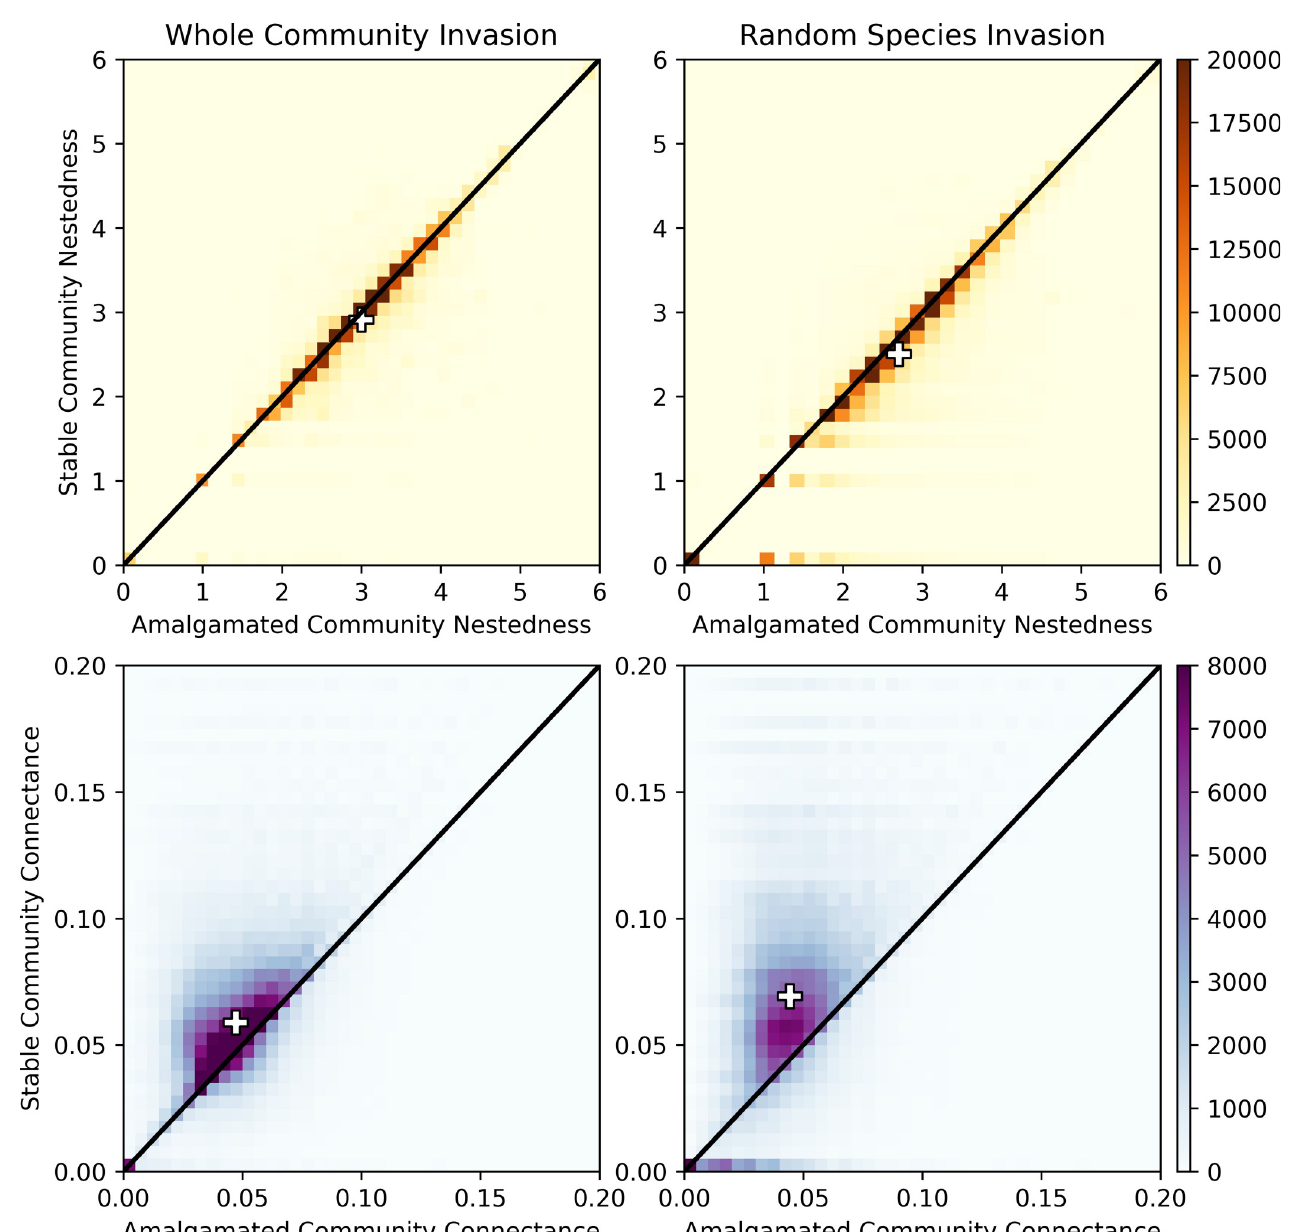
Fig 6. The nestedness (top) and connectance (bottom) of amalgamated vs. final stable communities; the figure shows invasion by both stable communities (left) and a random selection of species (right). Black lines show a 1:1 ratio for visual reference and the “+” symbols indicate the medians. For both invasion types the nestedness decreases slightly as a result of the invasion and the connectance increases; for both measures the shift is greater in the case of random species invasion. (Spearman correlation of -0.24 and -0.19 for whole community and random species invasion, respectively); see Fig 7. These findings differ from single species invasions, where an increase in species richness generally corresponded to increases in nestedness and decreases in connec- tance [82], suggesting that the impact of invasion by multiple species is not simply an additive effect from multiple individual species.